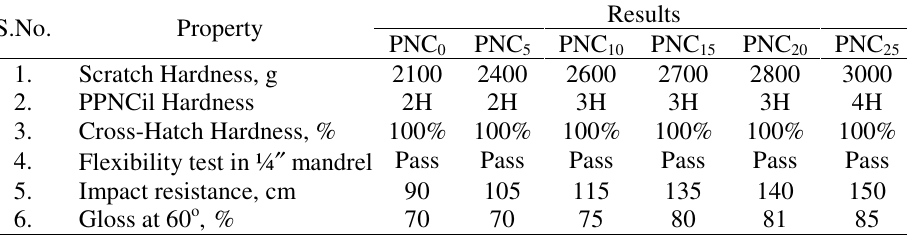
Table 2. Mechanical properties of modified epoxy and CTPB blend films.